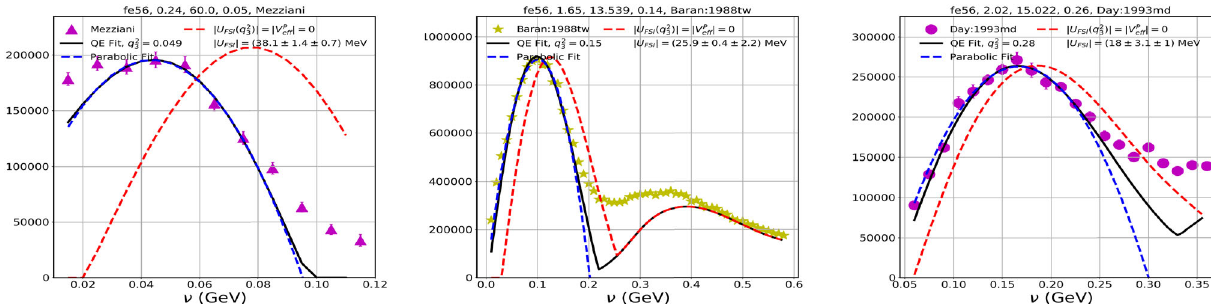
Fig. 14 Same as Fig. 8 for three of 30 56